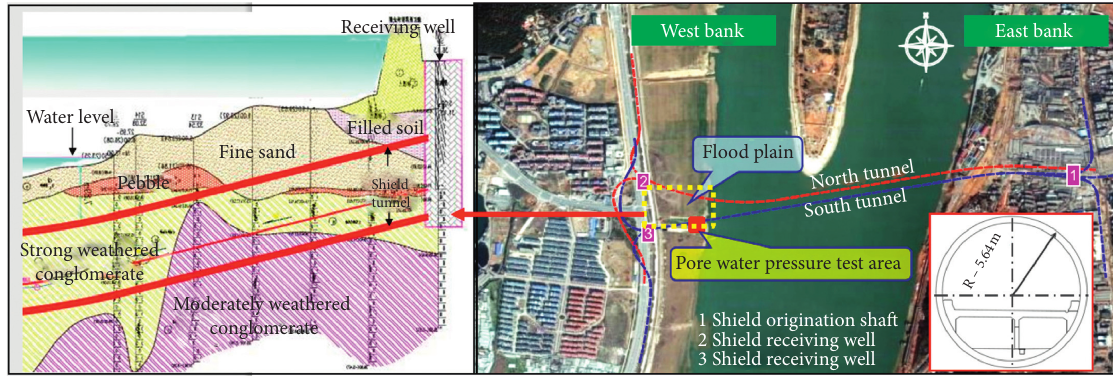
Figure 2: Overview of cross-river tunnel.